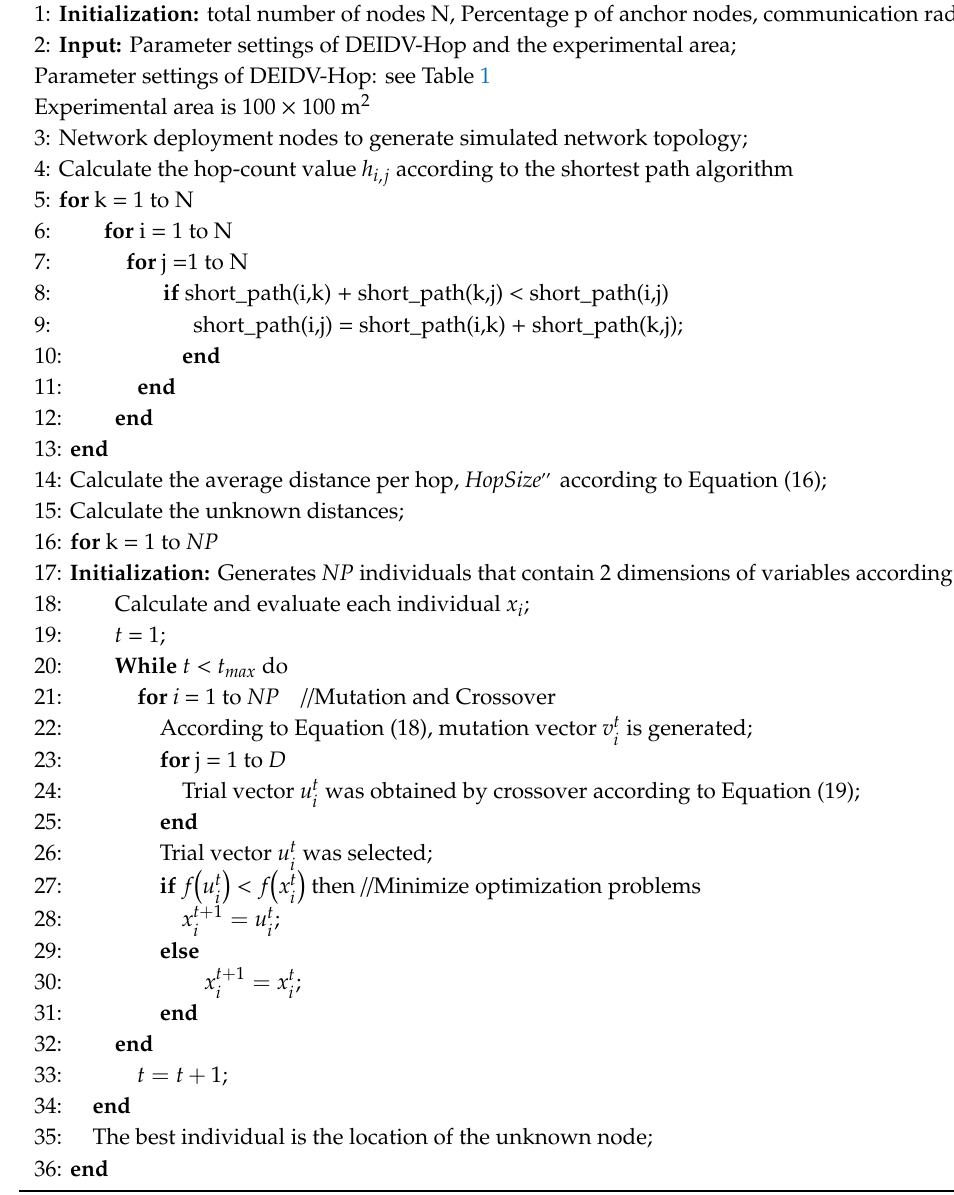
Algorithm 1: The procedure of DEIDV-Hop